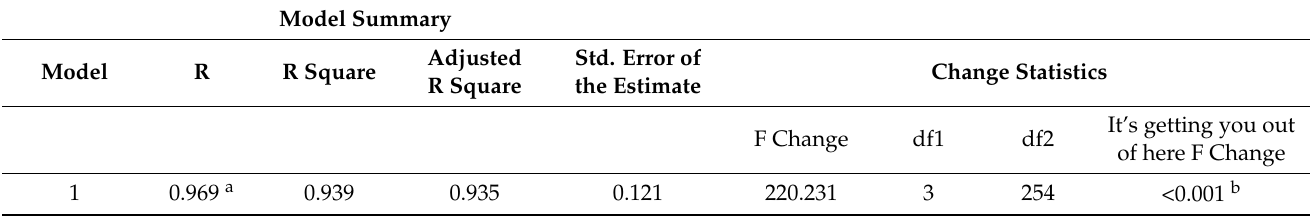
Table 14. Multiple regression analysis between the independent variables and the dependent variable on entrepreneurial intentions for 254